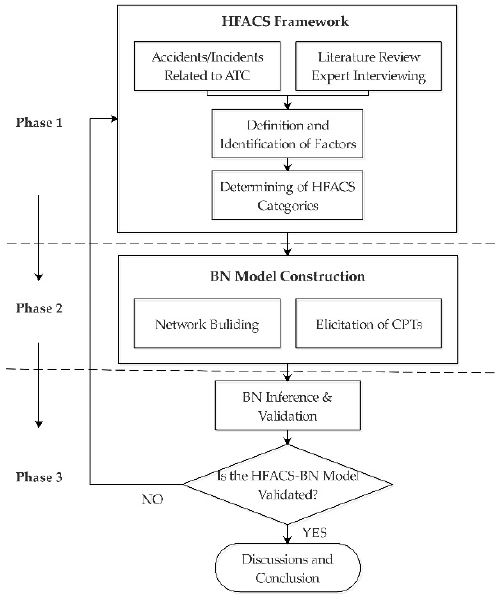
Figure 4. Research framework.